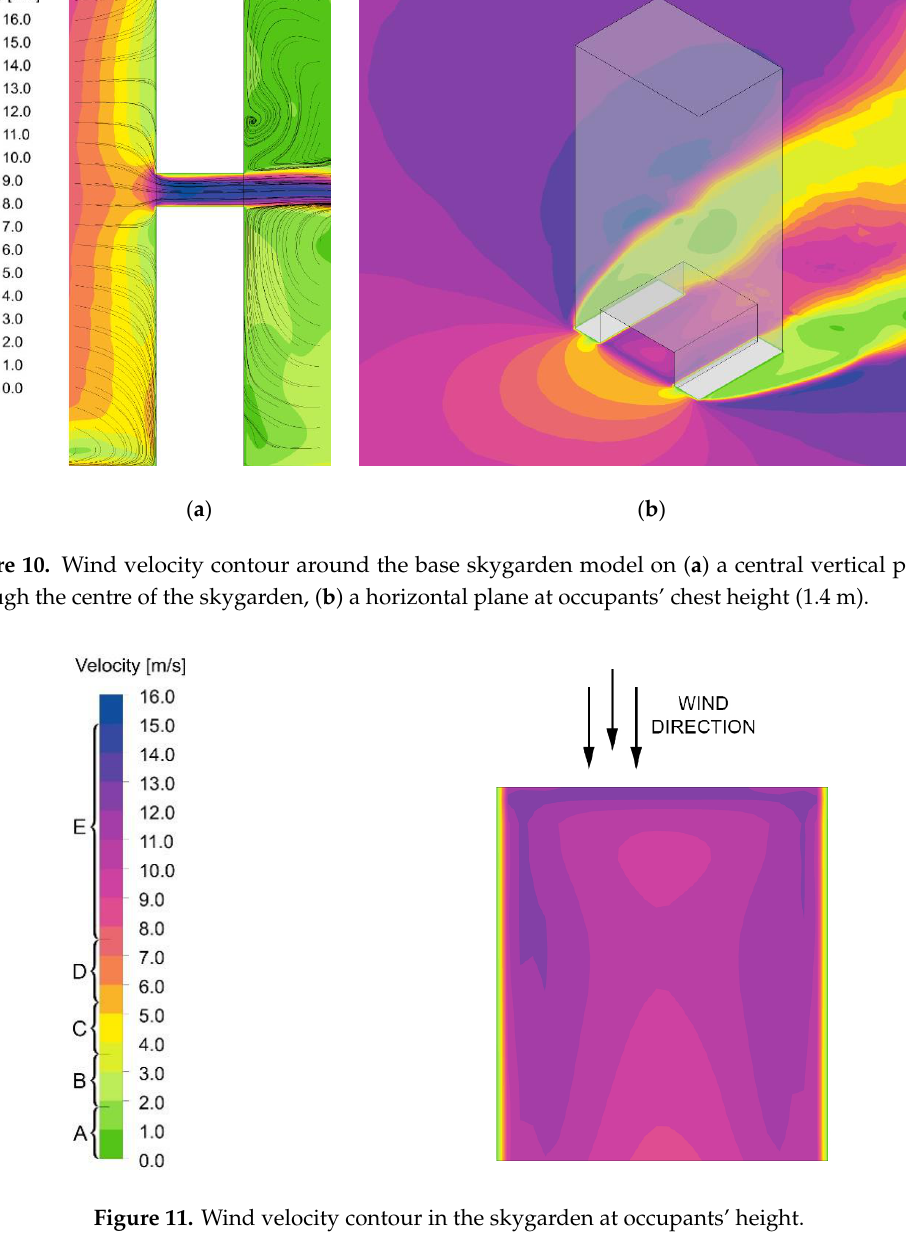
Figure 11. Wind velocity contour in the skygarden at occupants’ height.